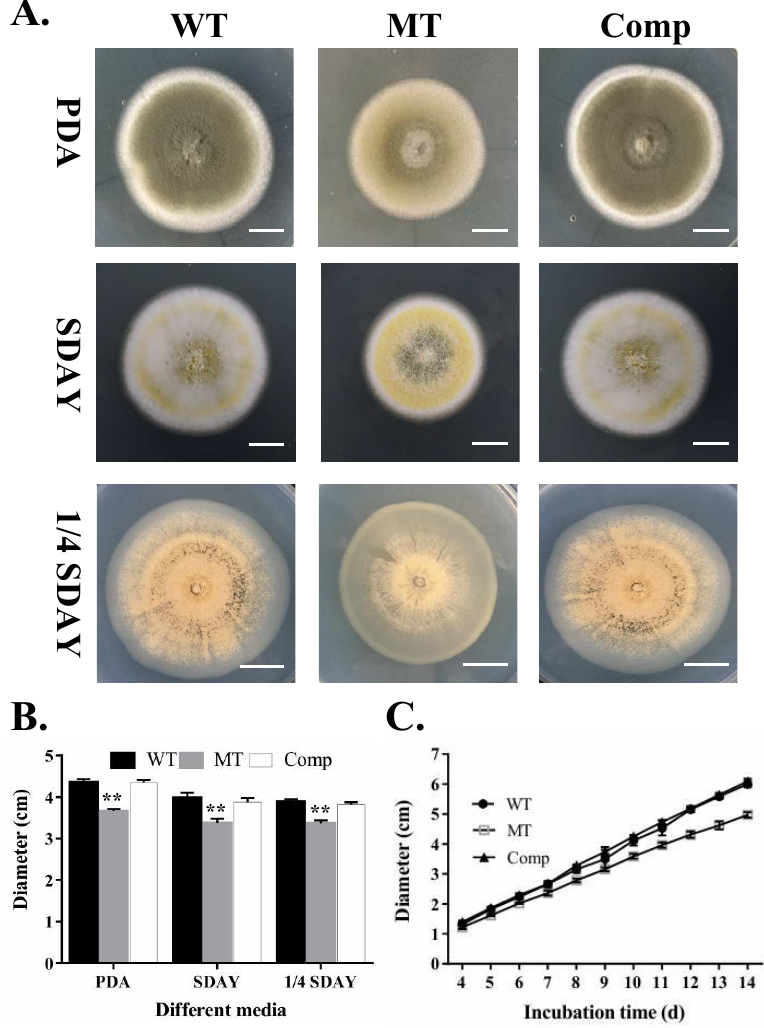
Figure 2. E ff ects of MrUBI4 deletion on vegetative growth. (A) Colony phenotyping of the WT and mutant strains on PDA, SDAY, and 1 / 4 SDAY plates after growing for 10 days at 25 ◦ C. Scale: 1 cm. (B) Fungal colony diameters of 3 di ff erent strains on PDA, SDAY, and 1 / 4 SDAY plates after growing for 10 days at 25 ◦ C. (C) Fungal growth of 3 di ff erent strains during the 4-14 day cultivation period on PDA plates at 25 ◦ C, and the growth rates of the ∆ MrUBI4 strain reduced significantly (Tukey’s test, p < 0.01) after 4 days post-inoculation. **, p < 0.01. WT: wild-type strain, MT: ∆ MrUBI4 strain, Comp: complementary